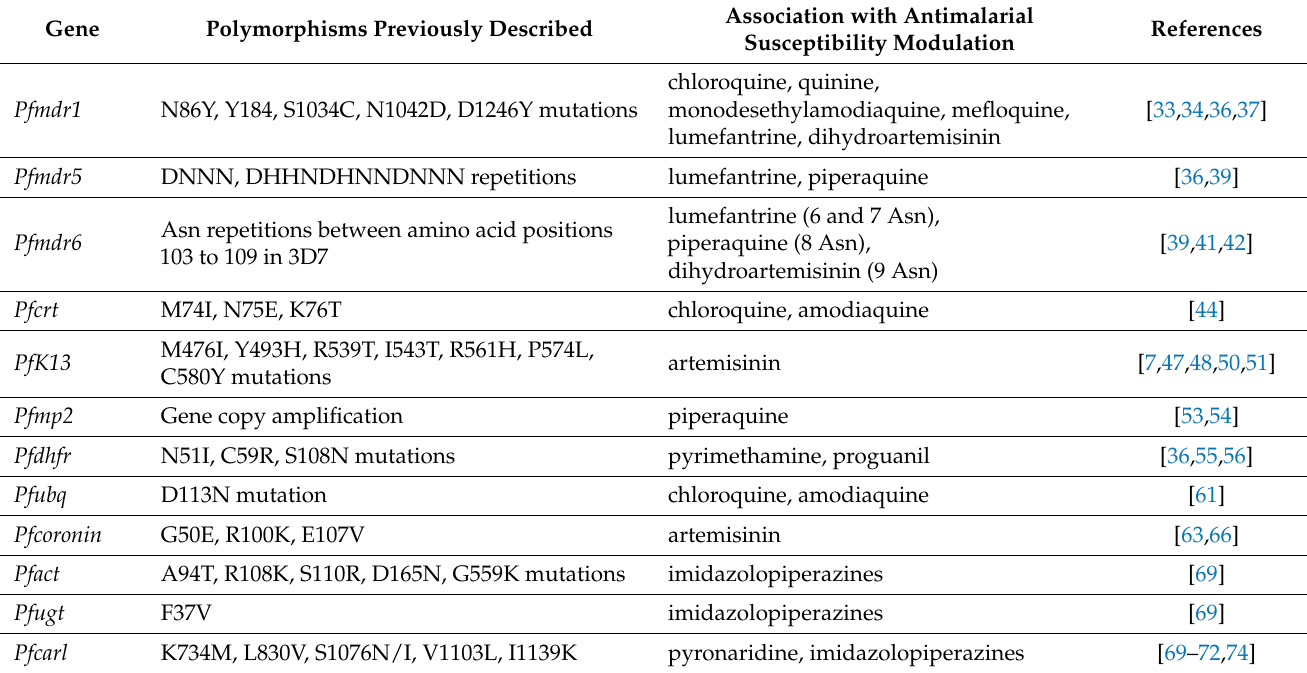
Table 1. Genes and their polymorphisms involved in modulation of the in vitro susceptibility to antimalarial drugs, assessed in the present work. Gene Polymorphisms Previously Described